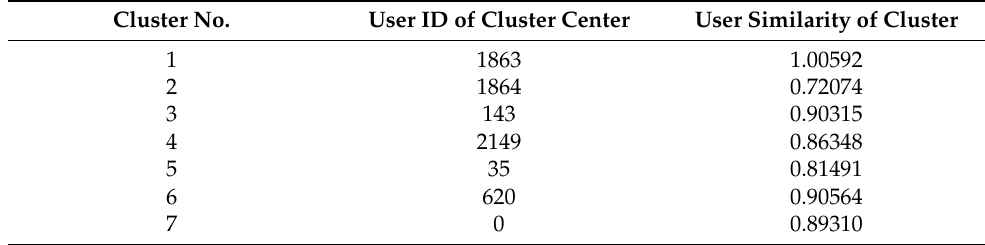
Figure 8. Maximum proportion of users and average user similarity. Table 4. User cluster information ( C = 7).